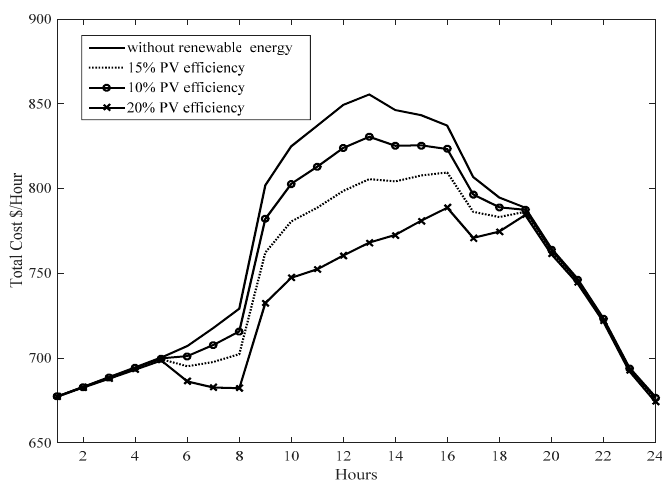
Figure 10. Effect of changing solar PV efficiency on total cost.